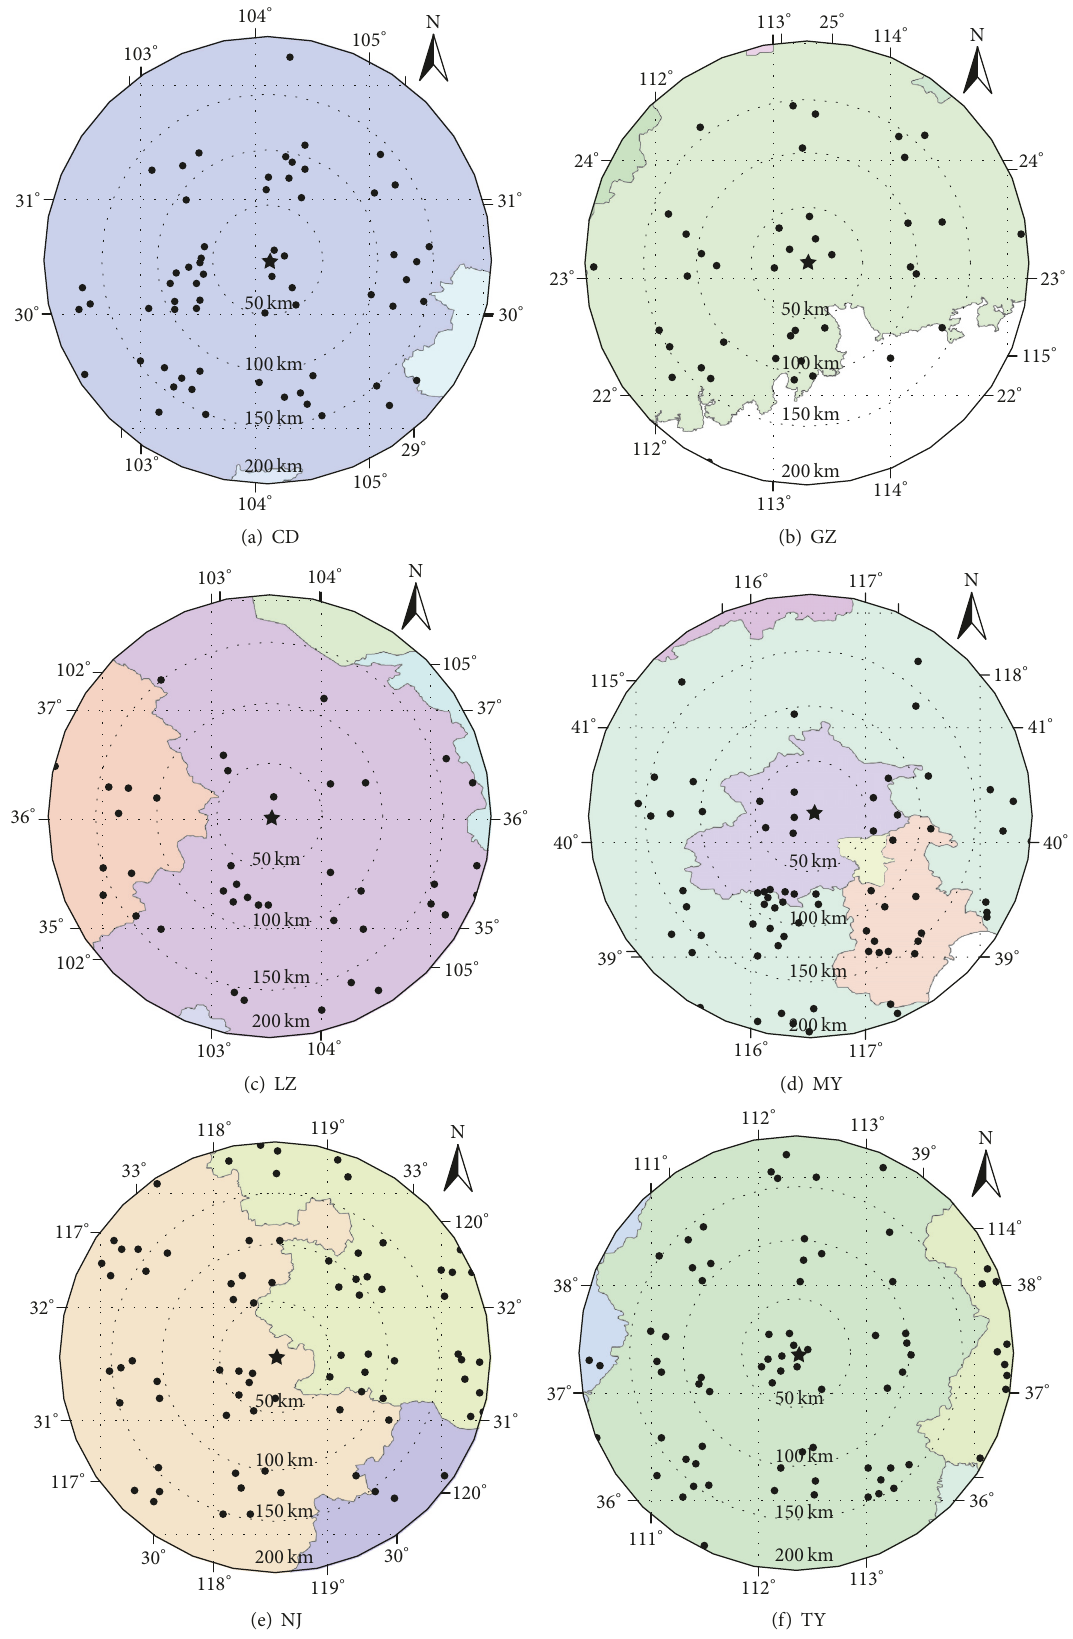
Figure 1: The distribution of the six target stations and their neighboring stations (within 200